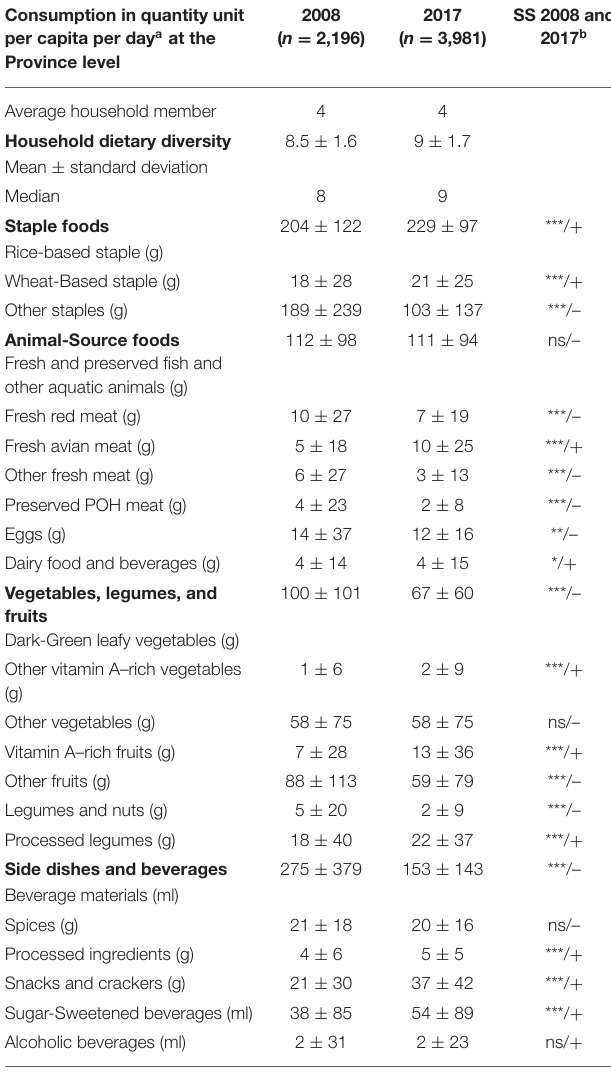
TABLE 1 | Consumption per food group and household dietary diversity in 2008 and 2017 in West Papua Province, Indonesia. Consumption in quantity unit per capita per day a at the Province